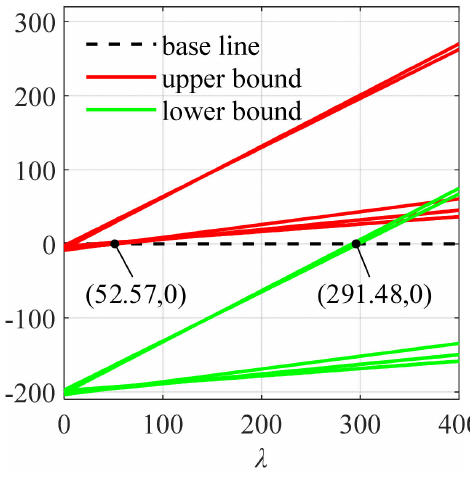
Figure 8. The solution of the value range of λ .